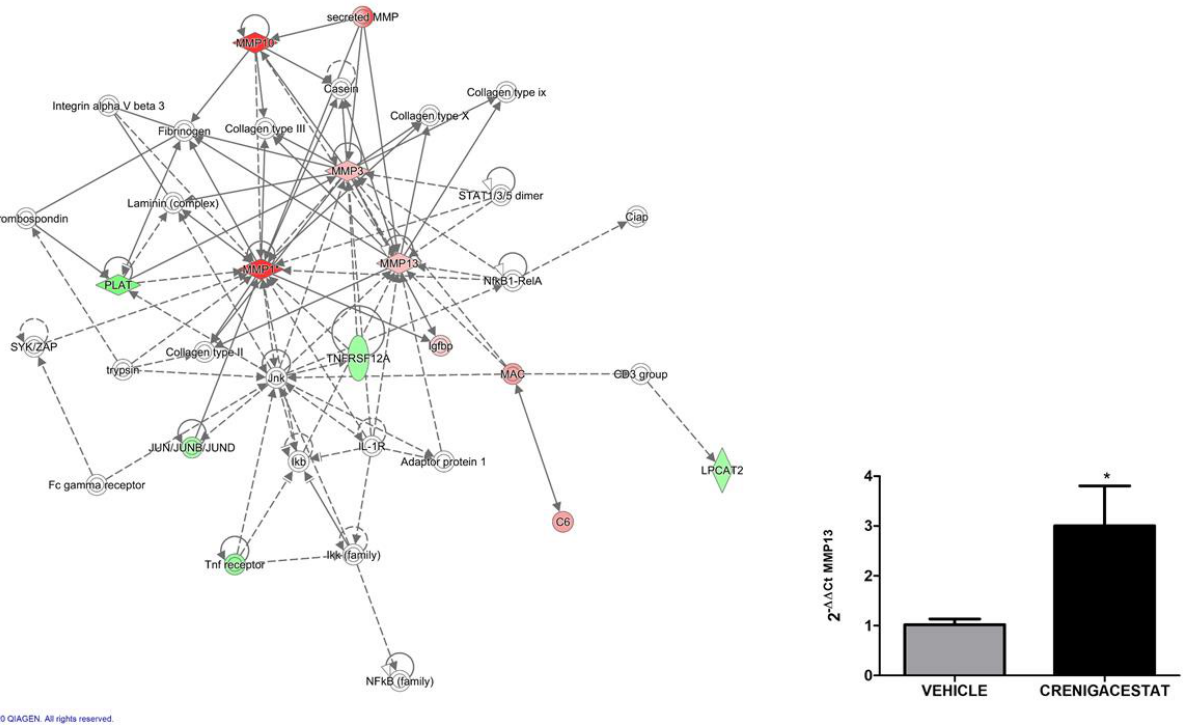
Figure 6. Network analysis with ingenuity pathway analysis (IPA) and microarray validation with real-time PCR. The analysis reports annotated interactions between genes modulated by Crenigacestat treatment in the HuCCT1-xenograft mouse model. The IPA functional category of this network was connective tissue development and function, connective tissue disorders, and organism injury and abnormalities. The Figure shows that even though Crenigacestat affected some metalloprotease (MMPs) genes, key elements of extracellular matrix such as fibrinogen, some collagens, laminins, and integrin were not altered by treatment. Up- (red) and down- (green) regulated genes are indicated. Blank nodes were suggested by IPA as potential targets functionally linked to deregulated genes. Validation of the MMP13 gene identified a significant (* p < 0.05) up-regulation of MMP13 by quantitative real-time PCR.